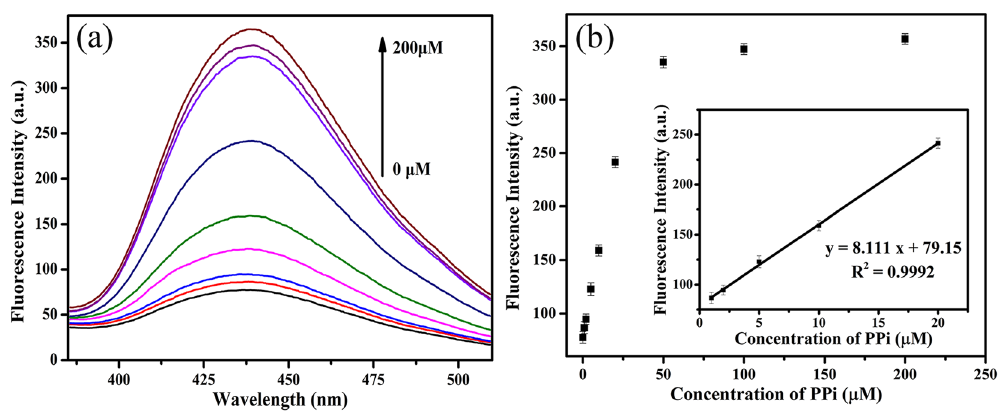
Figure 4. ( a ) Fluorescence spectra of the mixture containing N-CDs, Cu 2 + and increasing amount of PPi (0, 1, 2, 5, 10, 20, 50, 100, 200 μ M). ( b ) The fluorescence intensity of the mixture versus the concentration of PPi. Inset: The fitting curve between fluorescence intensity and PPi